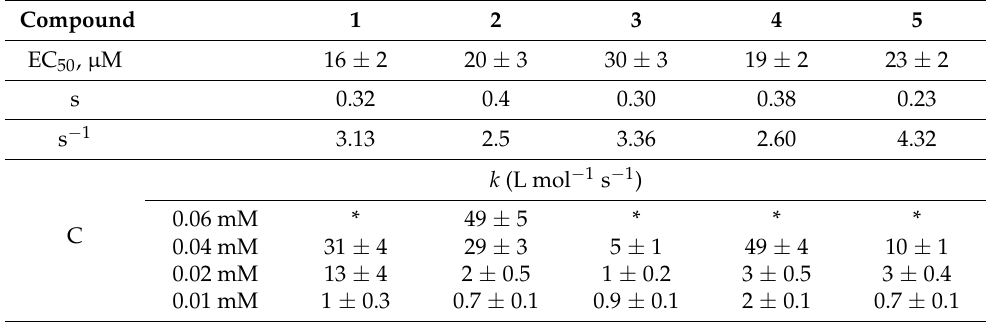
Table 4. EC 50 and k values in the DPPH test (EtOH, 20 ◦ C) in the presence of 1 – 5 .